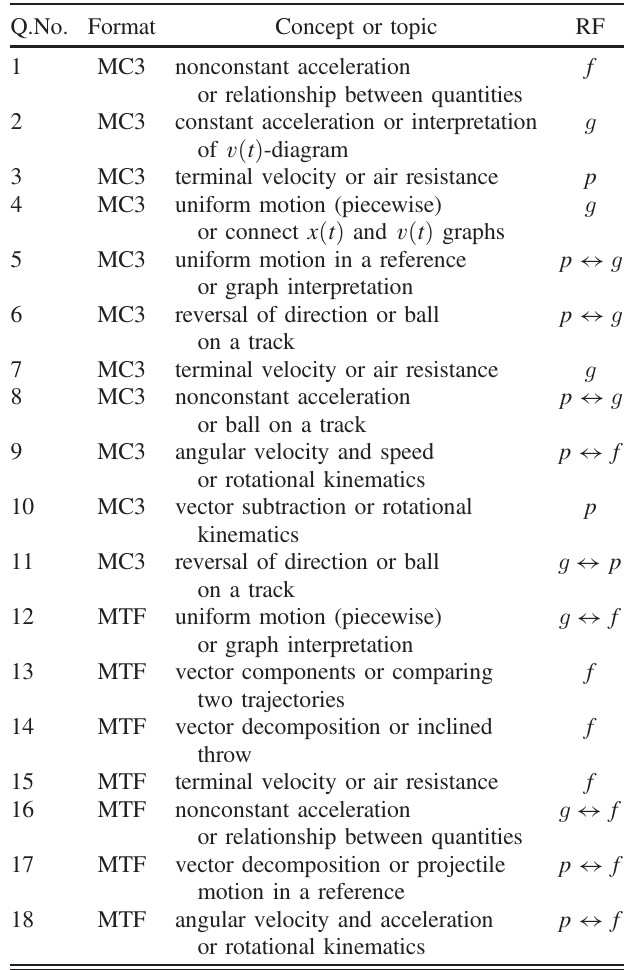
TABLE I. Item format, item content, and representation formats (RF) covered by the KiRC inventory: primarily formal ( f ), pictorial ( p ), graphical ( g ), and transitions between them ( g ↔ f , p ↔ g , and f ↔ p ). Test items are provided as Supplemental Material